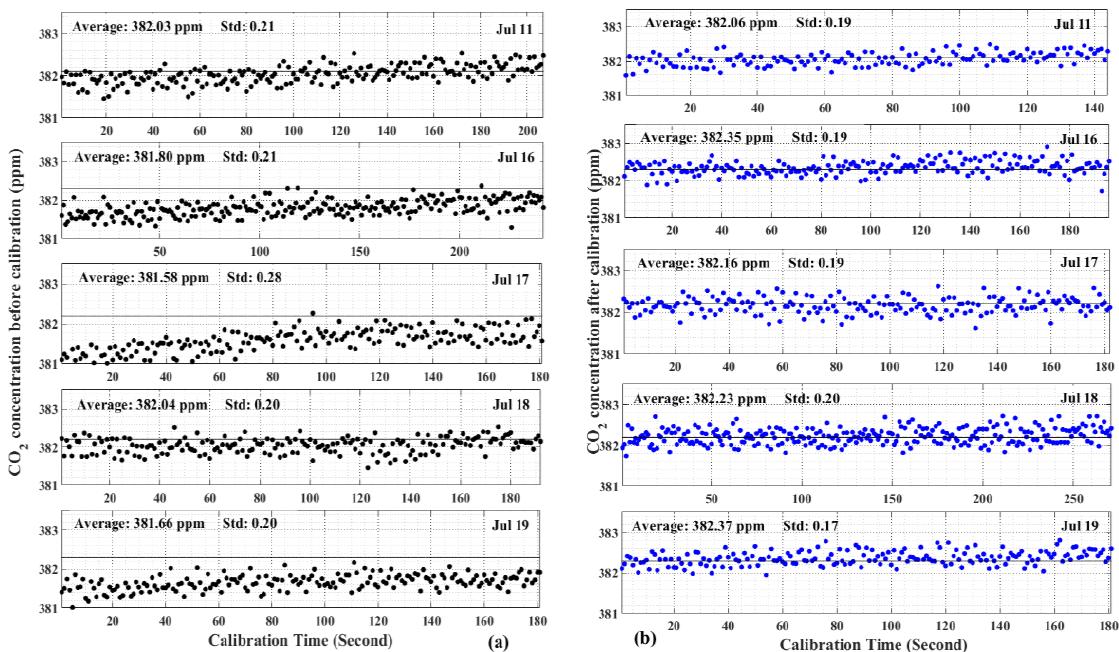
Figure 7. The concentrations of CO 2 measured by the UGGA before calibration ( a ) and the concentra- tions of CO 2 measured by the UGGA after calibration ( b ). The black straight line is the concentration value of the standard